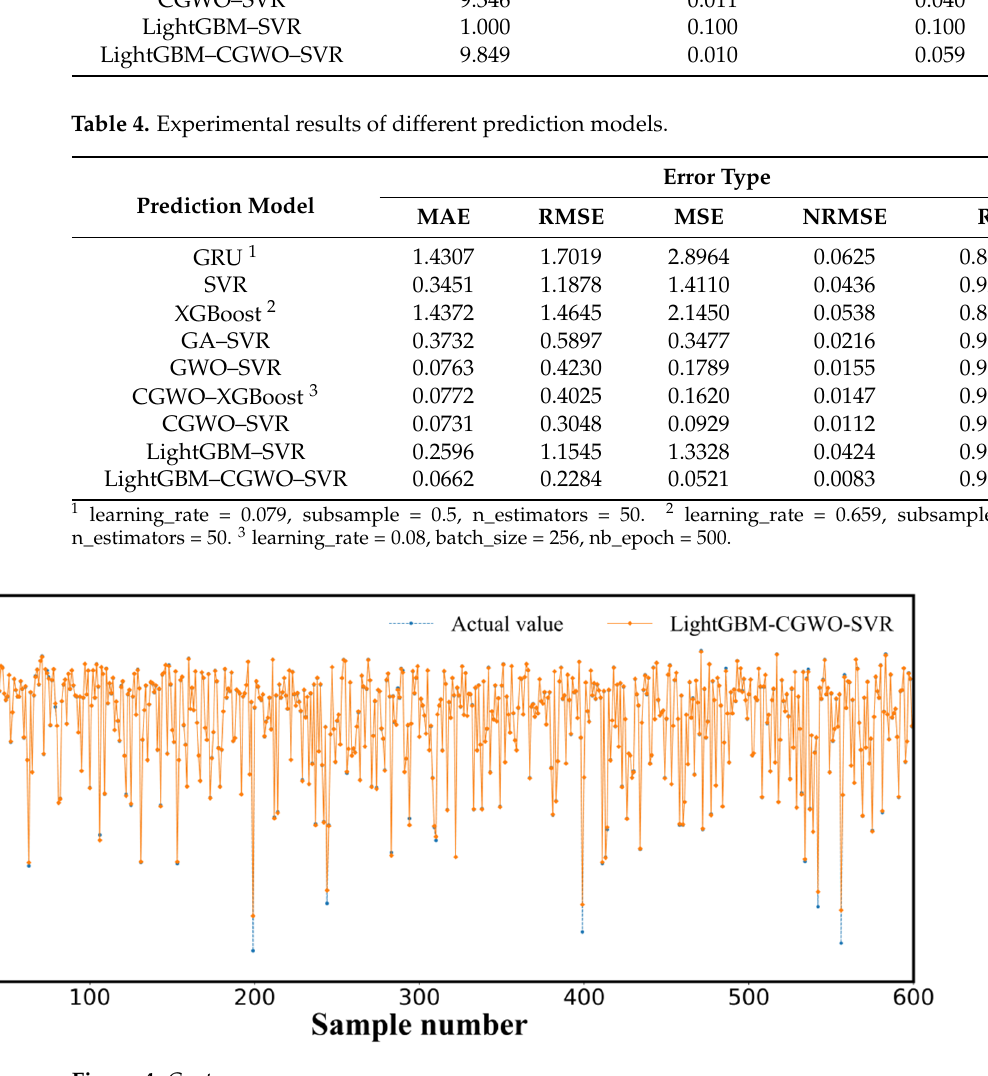
Table 3. Parameters of different SVR models in experiment.